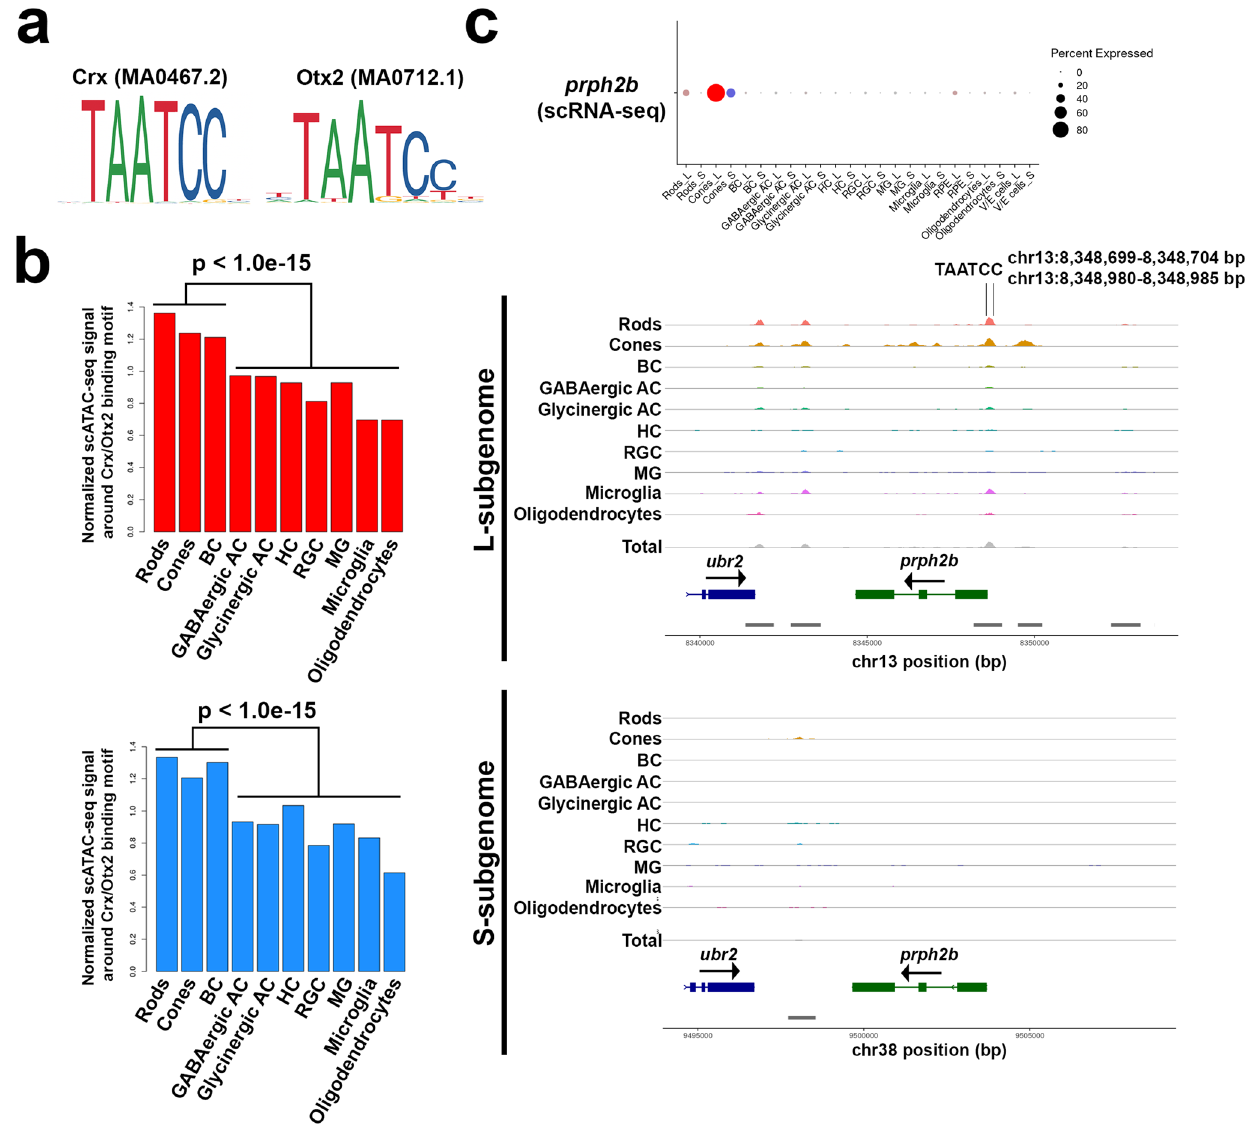
Fig. 7 Analysis of Otx2/Crx binding sequence based on scATAC-seq. a Binding motif of Crx and Otx2. IDs in parentheses come from JASPAR 68 . b Median value of normalized scATAC-seq signals around the Crx/Otx2 binding motif in each OCR is higher in rods, cones, and BC than in other cell types. Upper panel is for the L-subgenome and the lower is for the S-subgenome. c Expression pattern of the prph2b ohnolog pair (example of L-subgenome dominant ohnolog pair) based on scRNA-seq analysis data (upper panel). OCR peaks of the prph2b ohnolog pair are based on scATAC-seq data (lower panel). The expression data from scRNA-seq analysis is consistent with the results of scATAC-seq analysis. The genome annotation is based on the